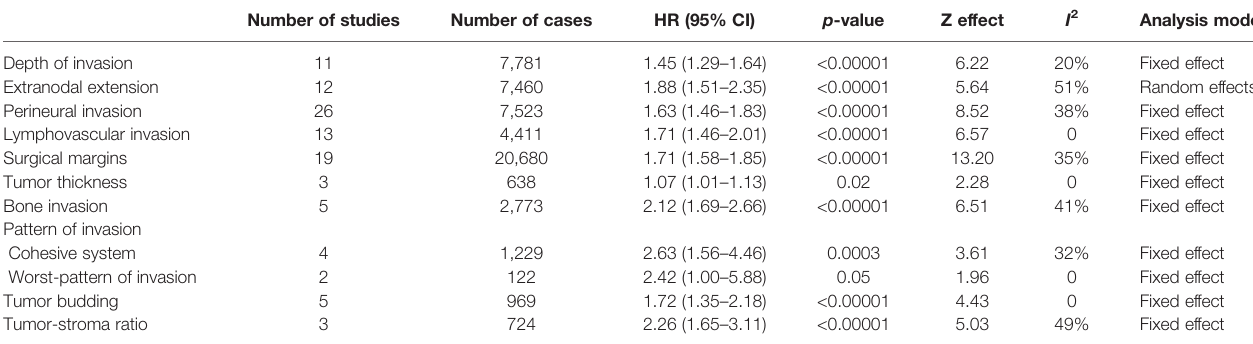
TABLE 2 | Effect of the selected histological features in the disease-speci fi c survival (DSS) of patients with oral squamous cell carcinoma. Number of studies Number of